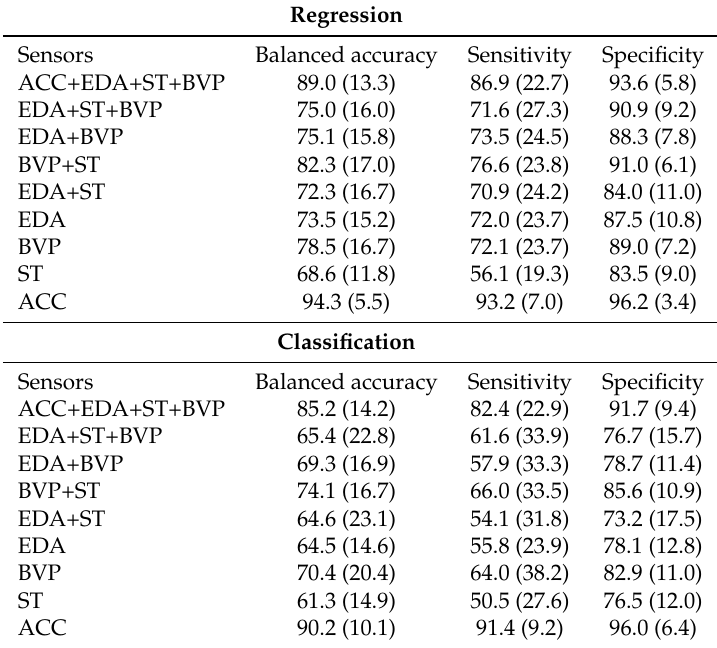
Table 2. Average recognition results accuracies, sensitivities and specificities (standard deviation in parentheses) using regression and classification model and sensor